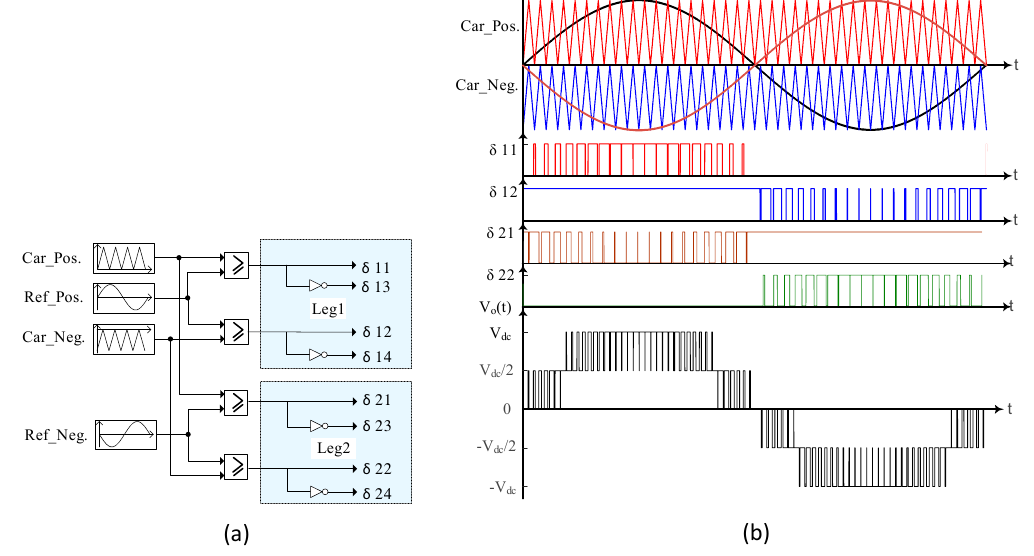
Figure 3. Switching pattern generation by classical Level Shift Pulse Width Modulation (LS-PWM): ( a ) block diagram; ( b ) switching orders and the output voltage V o (t).